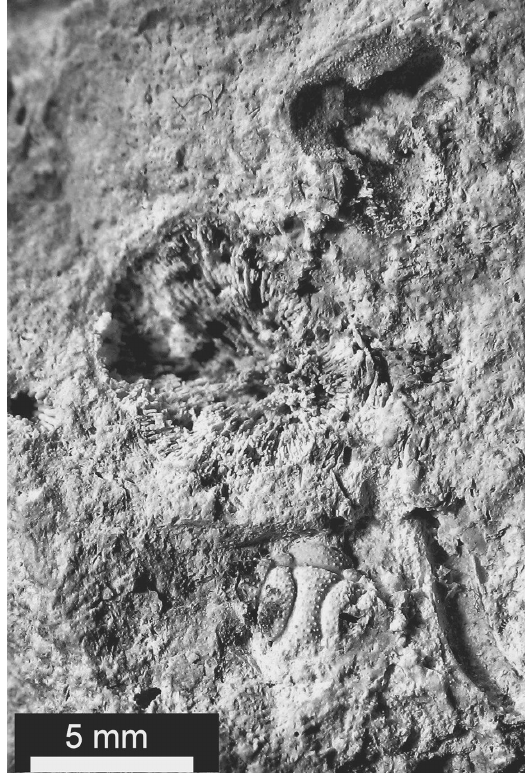
Fig. 11. Fragment of a type 1 boulder showing part of the cranidium of Otarozoum peri and two specimens of Solenopora spongioides . RGM 1317648, Wilsum.